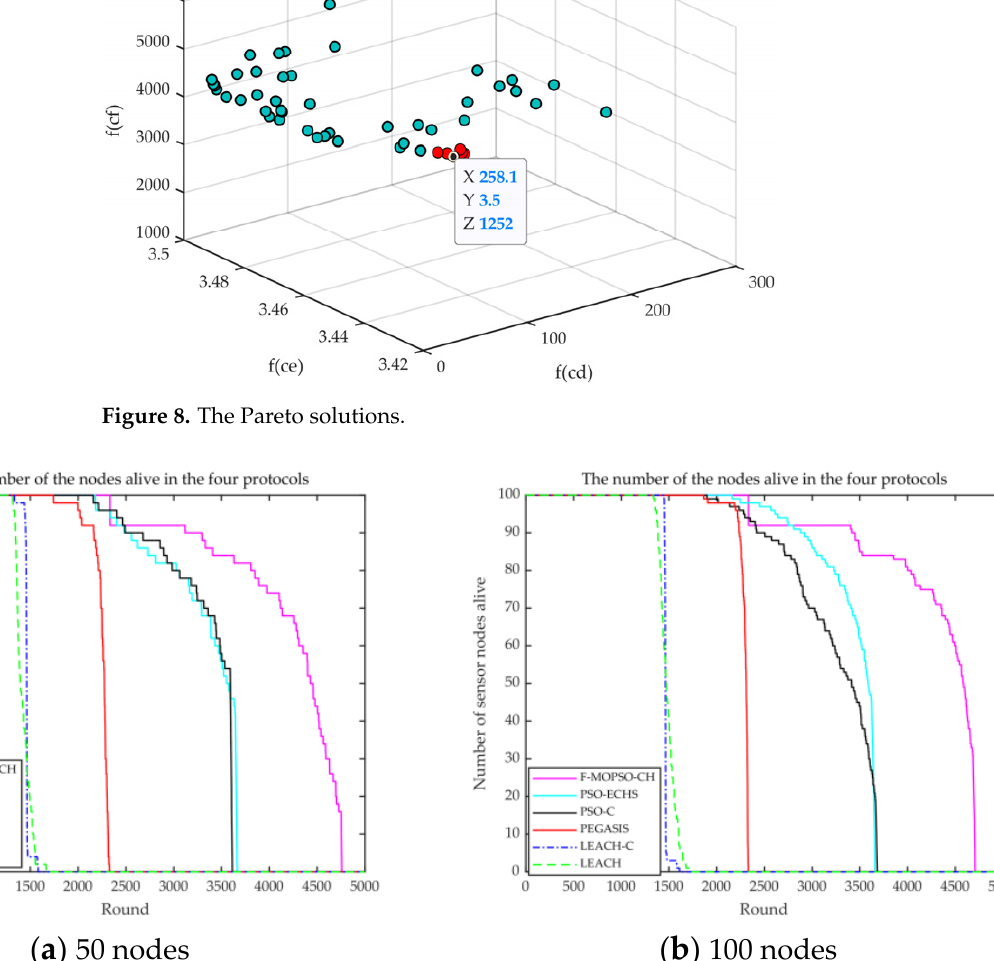
Figure 9. Comparison of the network lifetime for ( a ) 50 and ( b ) 100 nodes.